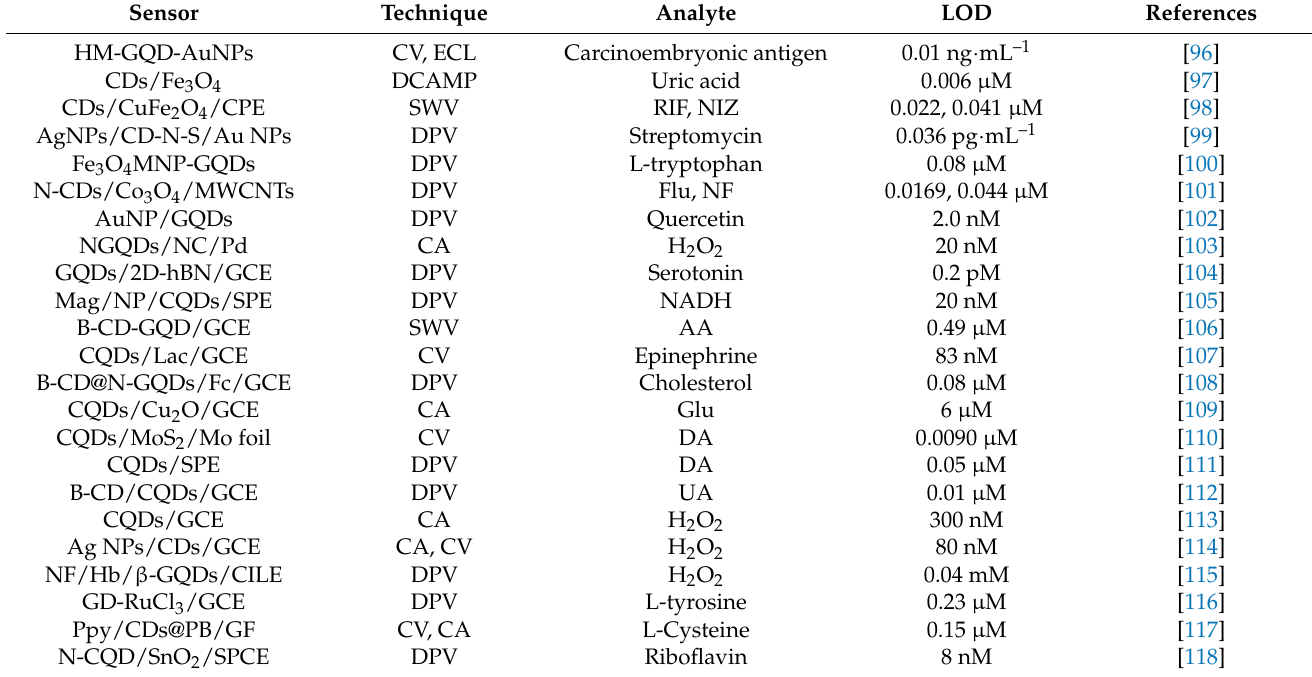
Table 3. Bioanalytes detected using carbon dot